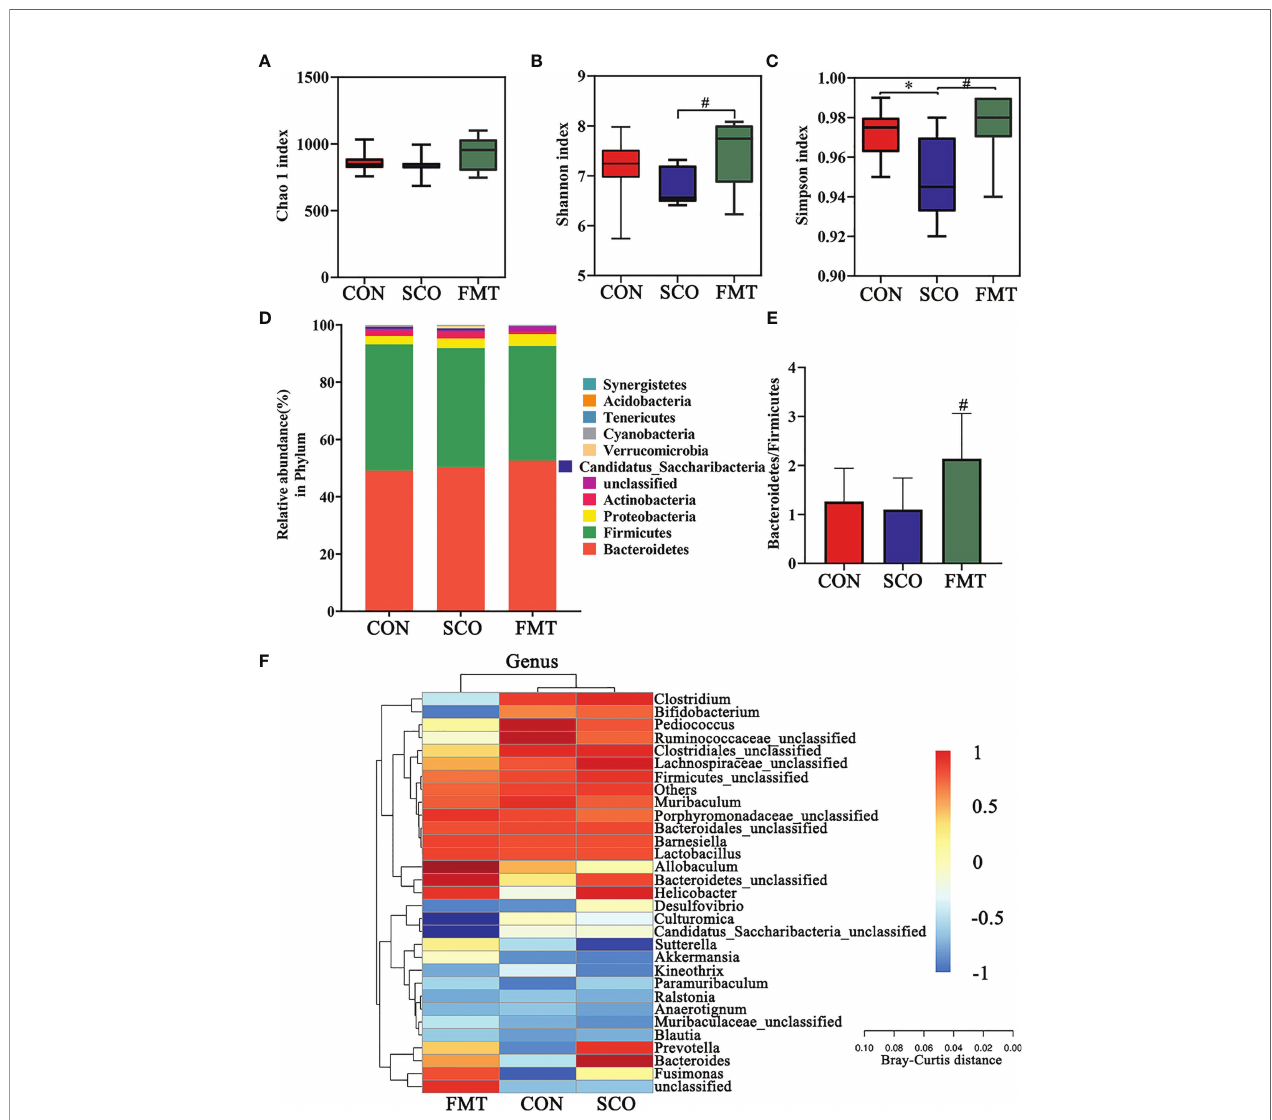
FIGURE 8 | Evaluation of 16S rRNA gene sequence analyzes of the CON, SCO and FMT groups: (A, B) a -diversity Chao1 (A) , Shannon and Simpson index (C) in each group; (C) clustering analysis of different metabolites in each group dominant phylum; and (D) correlation heatmap of gut microbiota and metabolite phylum (n = 8). (E) The ratio of Bacteroidetes / Firmicutes . (F) Correlation heatmap of gut microbiota and metabolite genera (top 30 general analysis) (n = 8). * p < 0.05 vs. CON, # p < 0.05 vs.